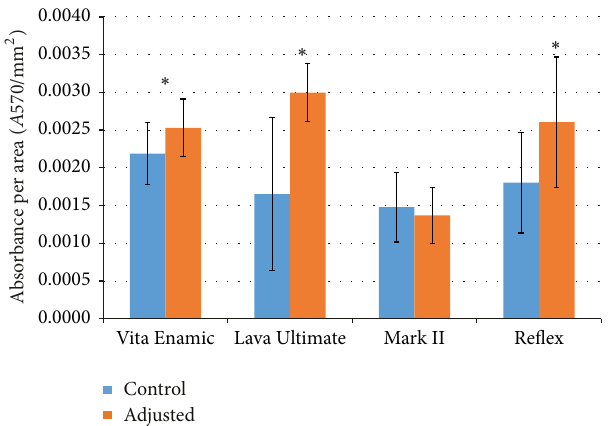
Figure 3: Comparison of biofilm development on control and adjusted surfaces of ceramic materials (average ± SD). ∗ Statistically significant ( 𝑝 < 0.05 , 95% confidence